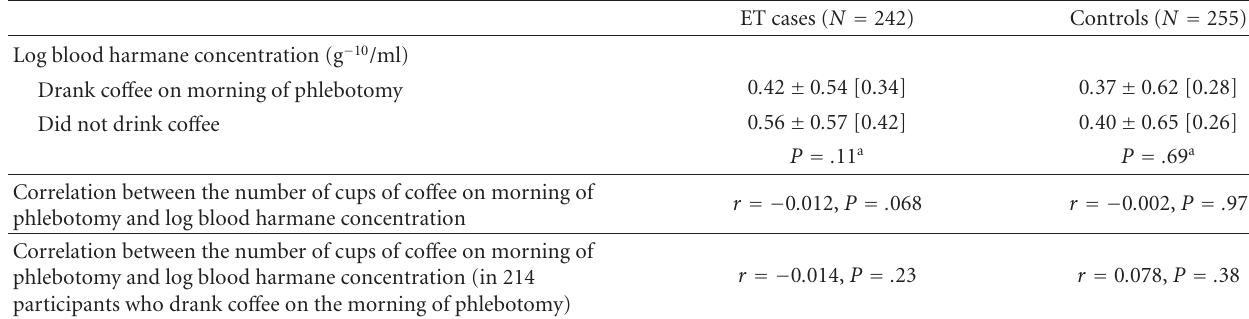
Table 2: Log blood harmane concentration and co ff ee consumption in analyses stratified by case-control status.